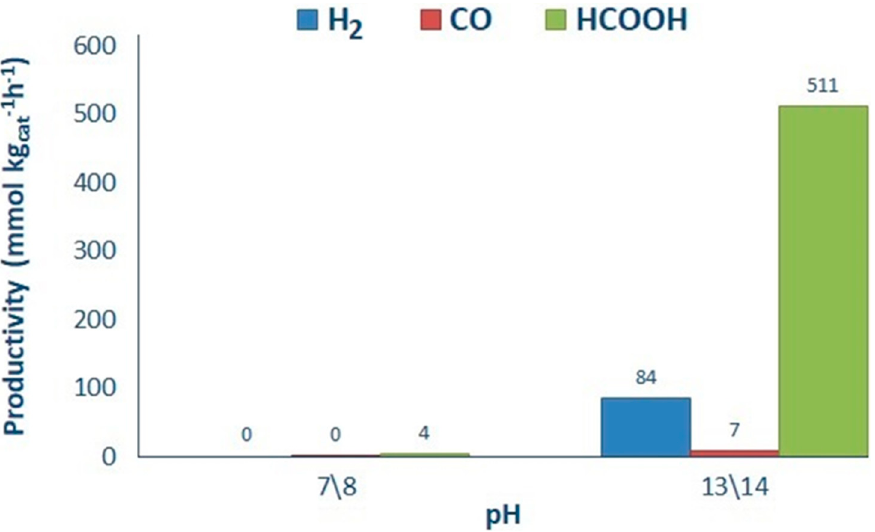
Figure 5. Influence of pH over productivity. Reaction conditions: 0.5 g L − 1 of P25, 1.66 g L − 1 HS.